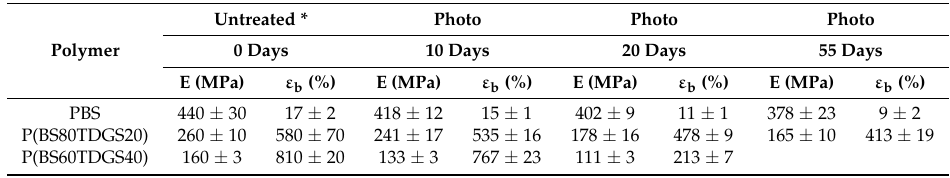
Table 8. Mechanical characterization data of PBS and P(BSxTDGSy) copolymers after photoaging in the range 0–55